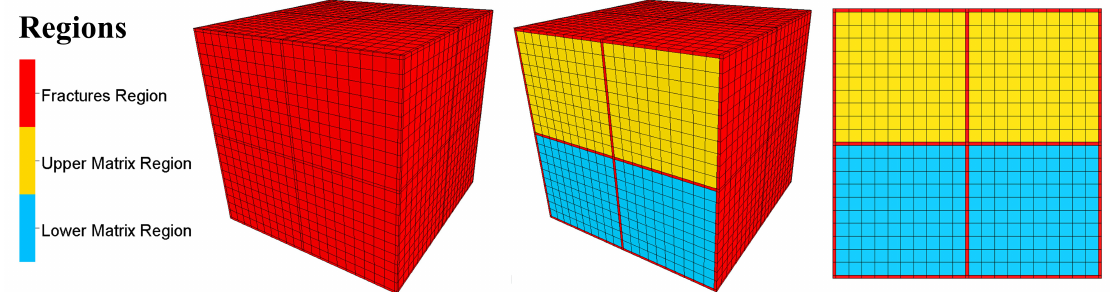
Figure 9. A small-scale model illustrating the configuration of the matrix blocks with their refinements surrounded by the fractures, based on Figure